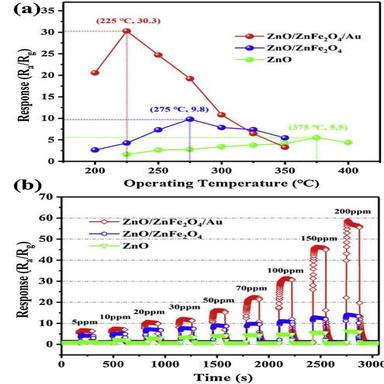
(a) Responses of the as-fabricated gas sensors towards 100 ppm of acetone as a function of the operating temperature; (b) responses of the sensors with respect to the varying acetone concentration at the optimum working temperature.